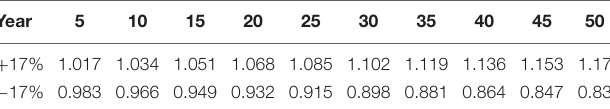
TABLE 2 | Growth multipliers applied in CBM-CFS3 where the first row represents gradual increased growth to reach + 17% site index by year 50 and the bottom row represents gradual decreased growth to reach − 17% site index by year